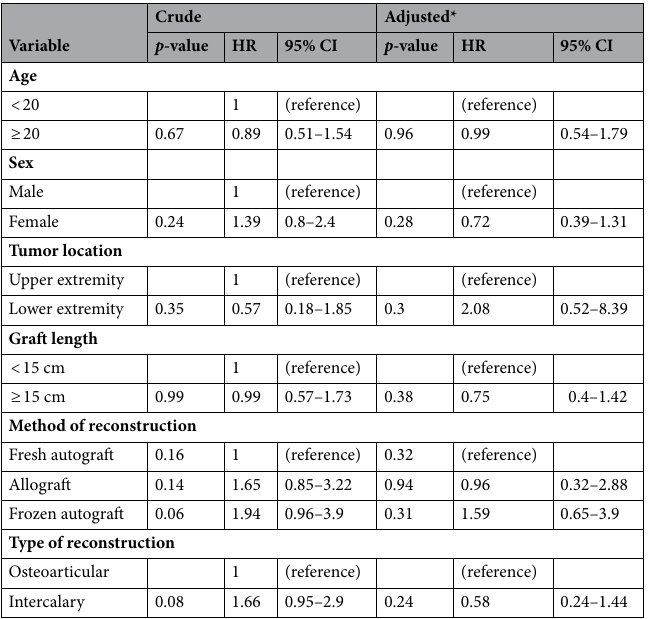
Table 3. Prognostic factors for failure of biological reconstruction. HR, Hazard ratio; CI, confidence interval. *Adjusted for age, sex, tumor location, graft length, method and type of